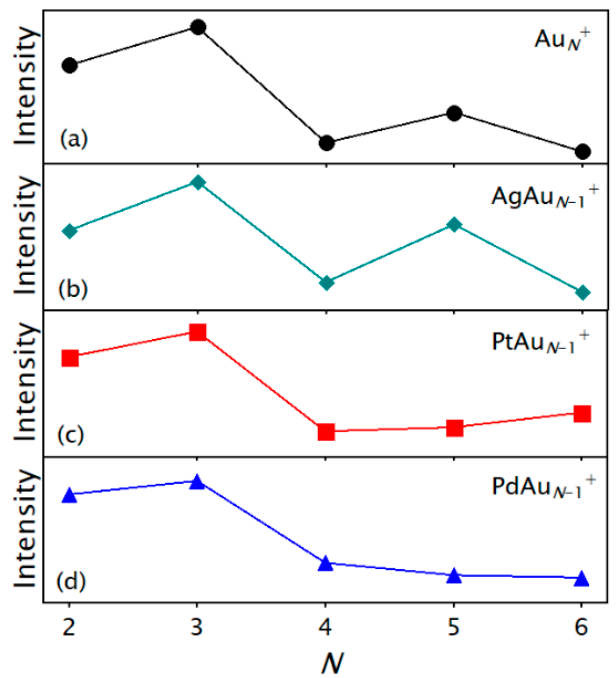
Figure 2. Abundances after photofragmentation for ( a ) Au N + , ( b ) AgAu N − 1+ , ( c ) PtAu N -1+ , and ( d ) PdAu N − 1+ clusters; these represent the relative stability of the different sizes. The values were calculated by integrating the area of the corresponding signal in the mass spectra.